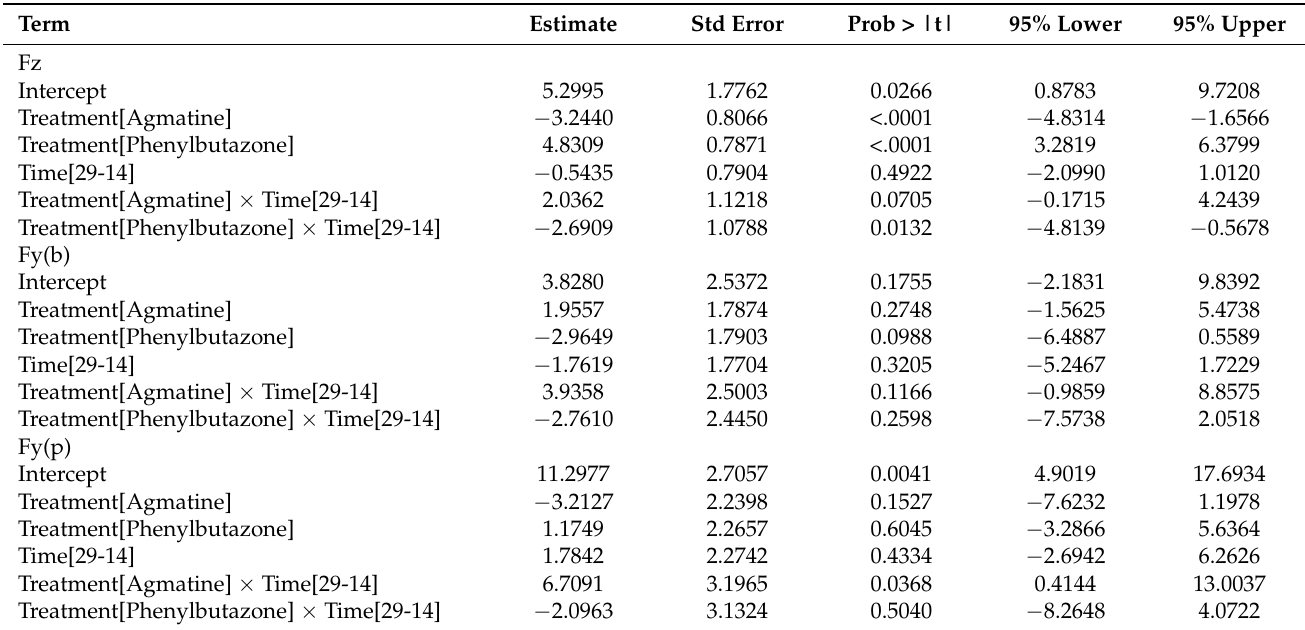
Table 6. Fixed effects parameter estimates of peak force percent changes. Std Error: standard error;